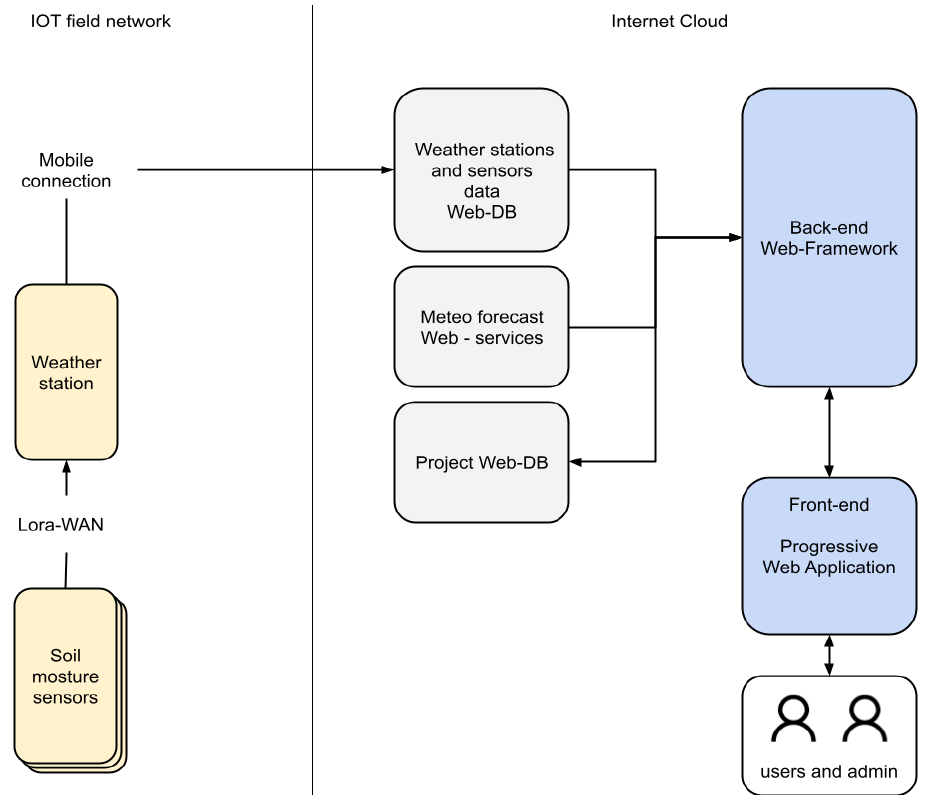
Figure 4. Field network and cloud components for data acquisition.